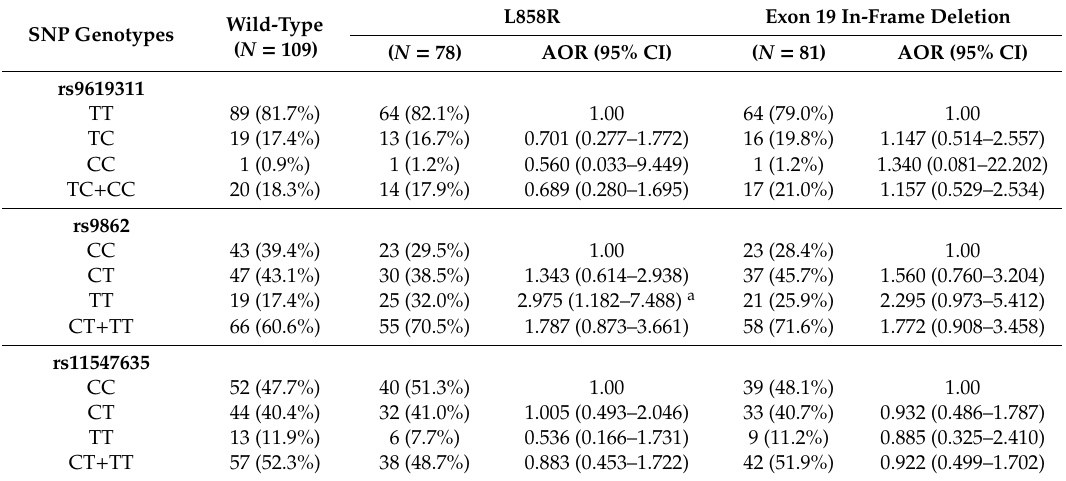
Table 4. Associations between the tissue inhibitor of metalloproteinases (TIMP)-3 genotypes with the epidermal growth factor receptor (EGFR) L858R mutation and exon 19 in-frame deletion in patients with lung